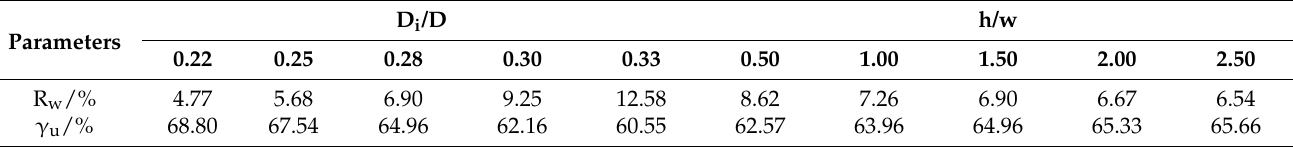
Table 2. Effects of inlet structure on the water split and recovery